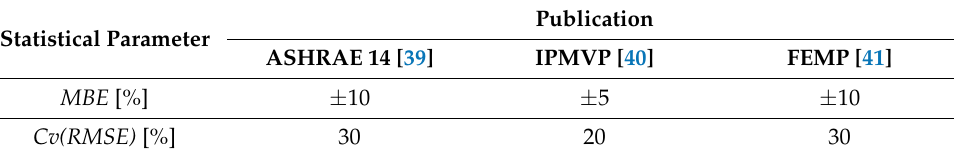
Table 4. Calibration criteria for the simulation models using hourly data. Statistical